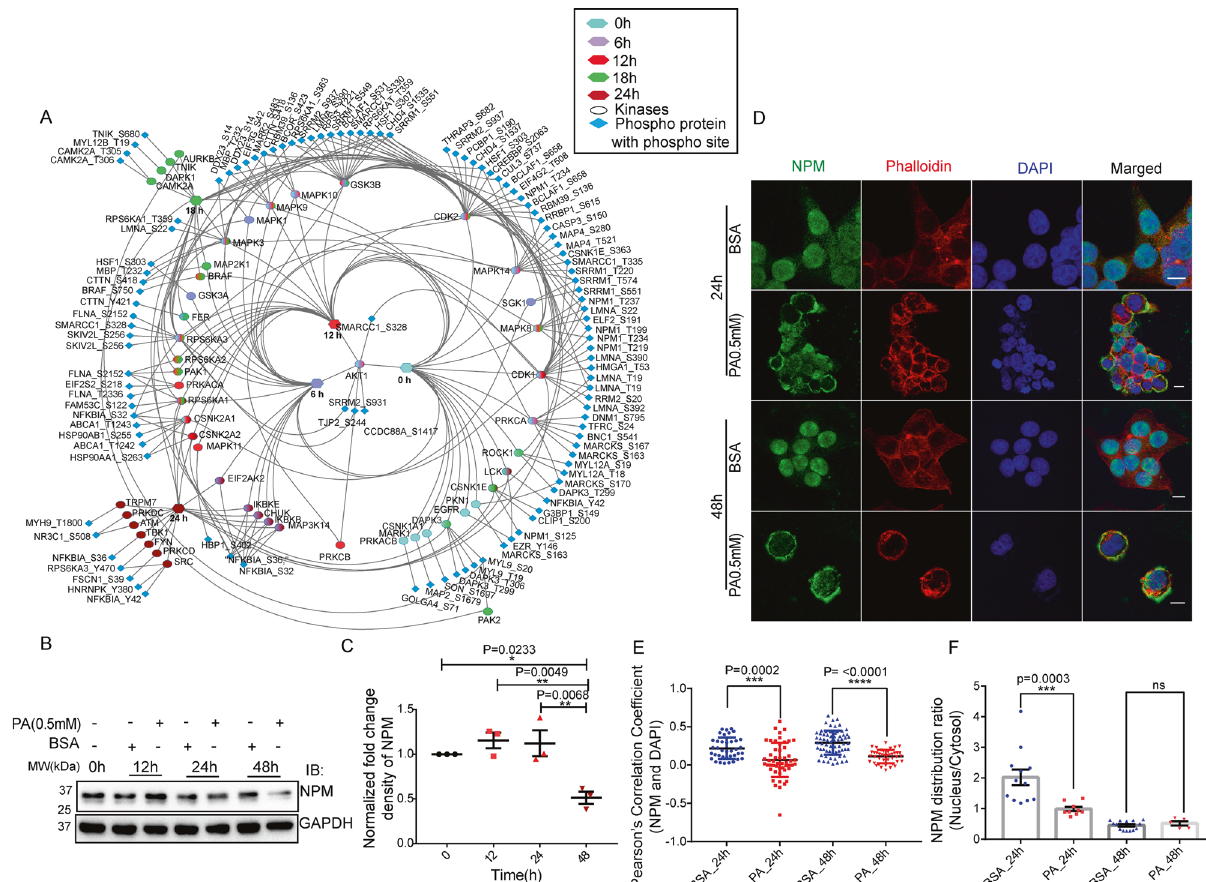
Fig. 7 Phosphoproteome analysis identi fi ed NPM1 as a regulator of mitotic catastrophe. A pictorial illustration of kinase-substrate interaction map throughout fi ve-time points (0, 6, 12, 18, and 24 h). The time points (de fi ne each node with individual color) were associated with phosphoproteins (middle shell) and their respective phosphosites arranged in the outer shell. The image was drawn in Cytoscape by using yFiles radial layout. Color gradient denoted the presence of those particular phosphoproteins among different time points ( A ). PA dynamically changes NPM expression. Western blot analysis of HepG2 cells was performed upon 0.5 mM PA treatment at 0 h 12 h, 24 h, and 48 h ( B ). GAPDH was used as a loading control. Proteins were quanti fi ed as a normalized fold change density compared to individual control conditions of particular time points. Ordinary one-way ANOVA followed by Tukey ’ s multiple comparisons test was applied for statistical analysis ( C ). PA alters the NPM localization in a time-dependent manner. Immuno fl uorescence analysis demonstrating NPM (green) distribution between the nucleus (blue, DAPI) and cytosol (red, MITO TRACKER) in HepG2 cells upon 0.5 mM PA treatment. The overlay channel for all merged conditions was shown on the right panel. Scale bar, 10 µm ( D ). Bar graph showing quanti fi cation of colocalization of Pearson ’ s value for NPM and DAPI ( E ). The representative bar graph represents the cellular distribution ratio of NPM (nucleus/cytosol) ( F ). The translocation ratio twofold reduced upon PA treatment at 24 h. Ordinary one-way ANOVA followed by Tukey ’ s multiple comparisons test was applied for statistical analysis. All error bars are showing mean ± SEM; n ≥ 3; * p < 0.05, ** p < 0.01, *** p < 0.001, **** p < 0.0001, and ns = non- signi fi